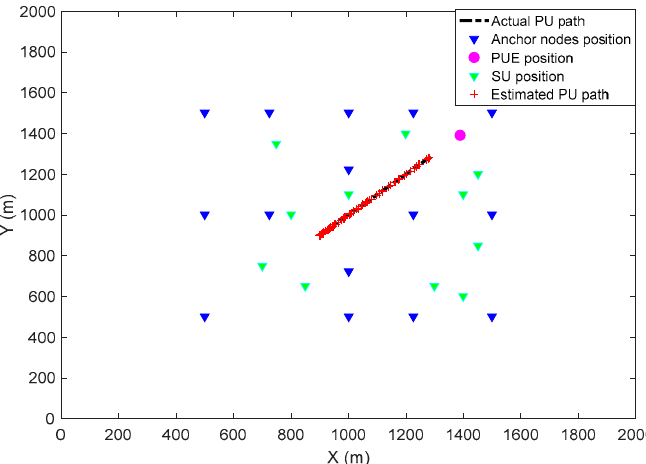
Figure 4. Simulation scenario of the mobile PU, the fixed PUE, SUs, and anchor nodes. The red symbols represent the predicted PU path after applying Kalman filtering with an optimal measurement noise value.